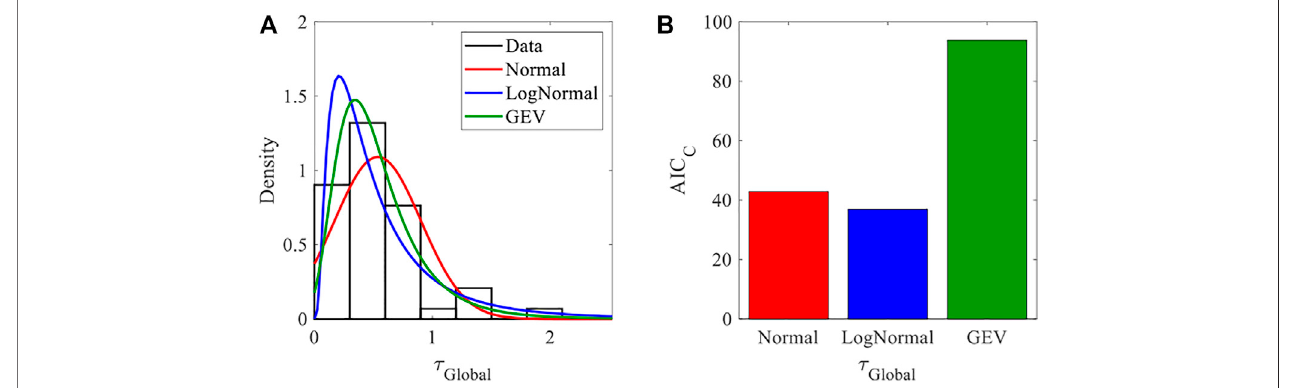
Frontiers in Built Environment |